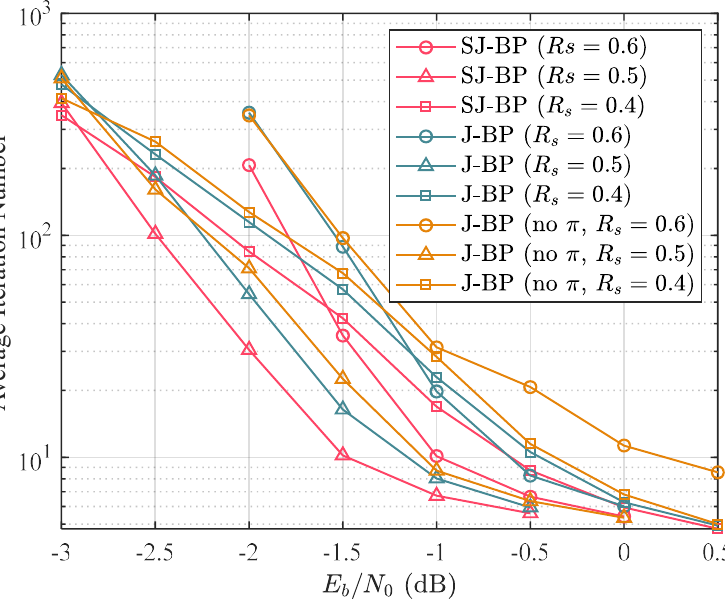
Figure 7. Average iteration number of J-BP decoder with p =